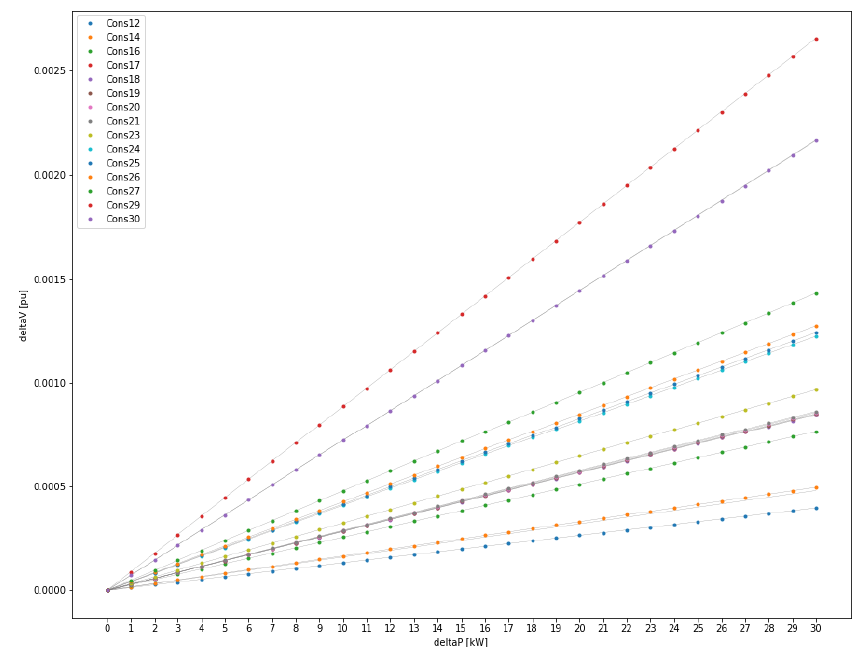
Figure 9. Dependences of increase in voltage on defined location on changes in loading of consum- ers nodes for one congestion event. Table 3. Impact of change in active power consumption of flexibility provider/asset on change in voltage at a node with the smallest voltage for given grid condition. Flexibility